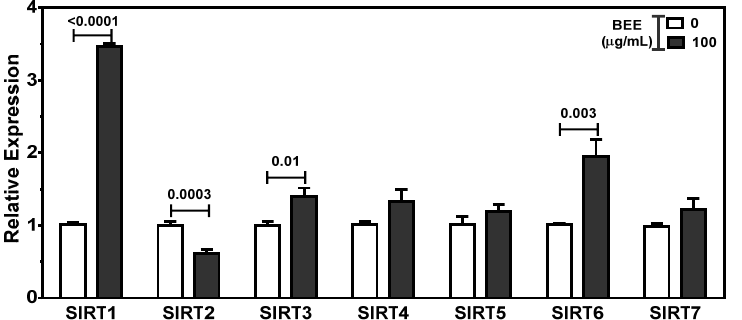
Figure 6. The effect of BEE on the expression of sirtuins (SIRTs) in Caco-2 cells. Cells were treated with 100 µ g/mL BEE for 24 h. The expression of SIRT isoforms was measured by qRT-PCR. Data are expressed as relative expressions of control. P values of significant differences are shown as above bars. Values are means ± SEM; n = 6.